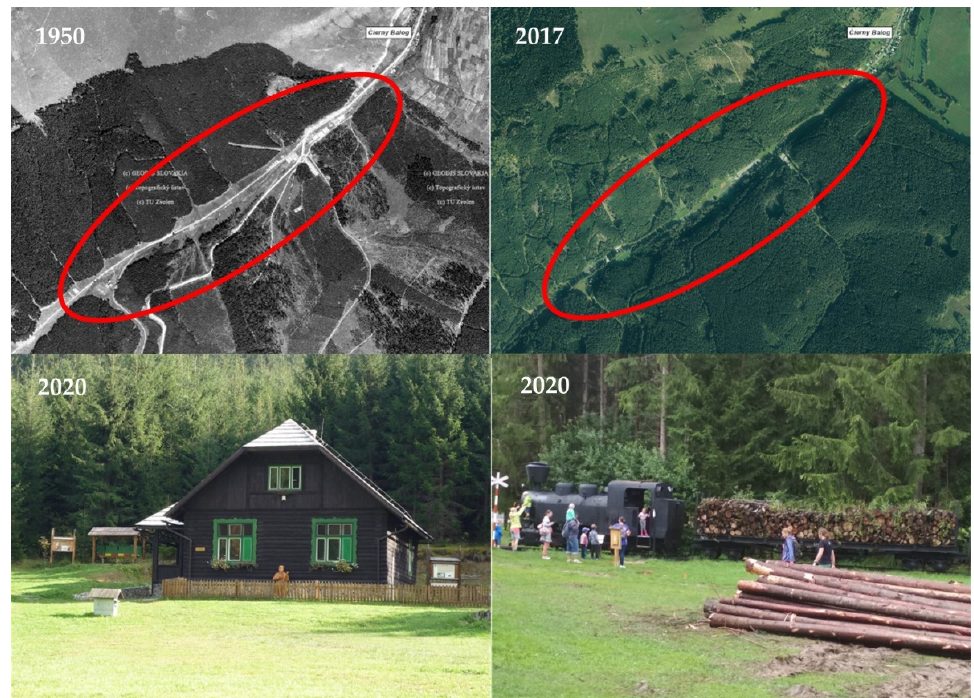
Figure 8. Visual interpretation of the Č ierny Balog (Vydrovská Dolina Valley) site. Source: 1950—Adapted with permission from ref. [37]. Copyright 2021 GEODIS SLOVAKIA, s.r.o. Bratislava, Topografický ústav Banská Bystrica. 2017—Adapted with permission from ref. [38]. Copyright 2021 GKÚ Bratislava, NLC Zvolen. 2020—author’s photo.